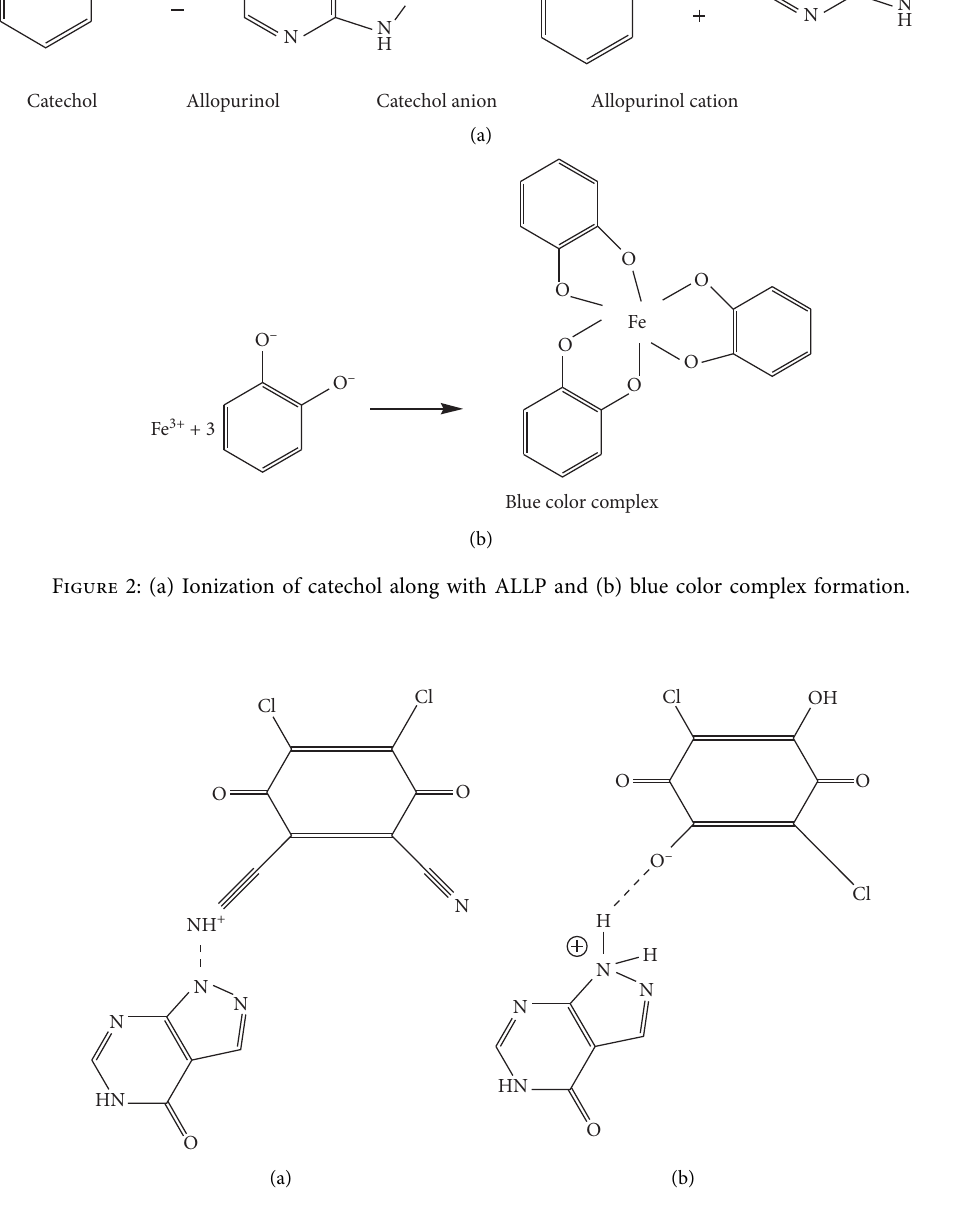
Figure 3: (a) Structure of the ALLP-DDQ CT-complex; (b) structure of the ALLP-p-CLA